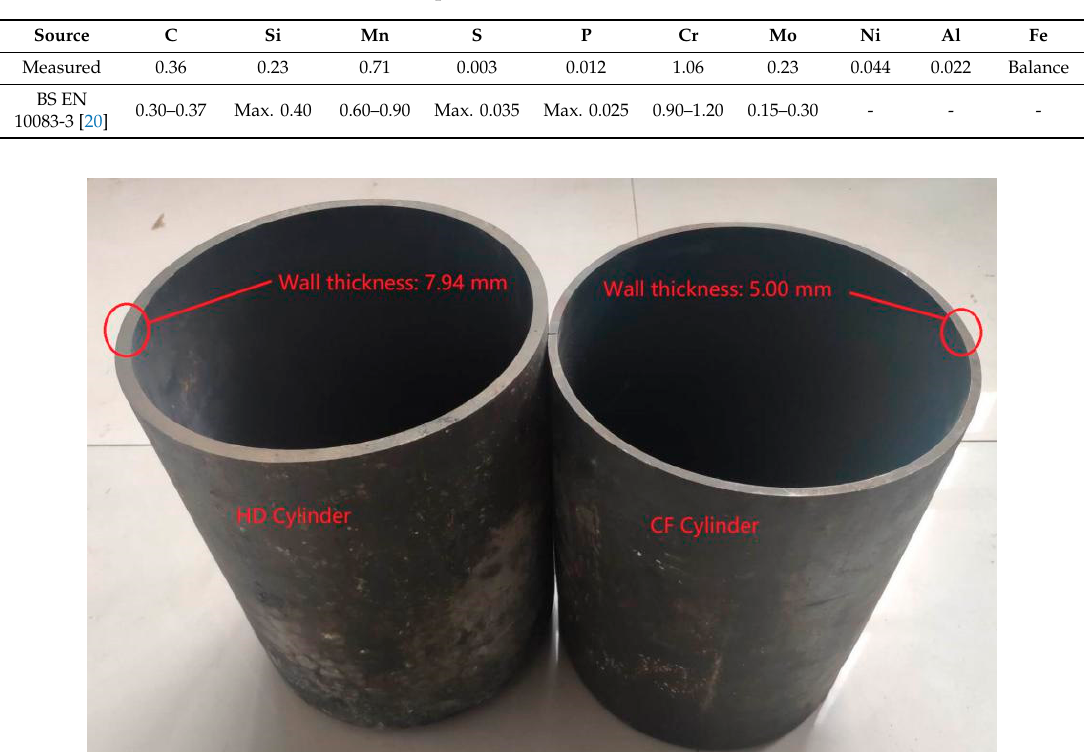
Figure 1. Gas cylinders with a diameter of 210 mm used in this work, including the hot drawing cylinder (HD) and the cold flow-formed cylinder (CF).